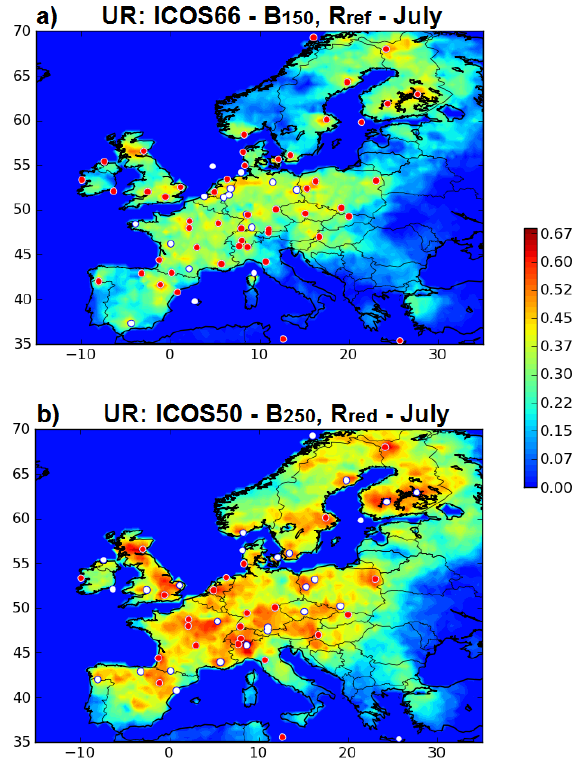
Figure 10. Uncertainty reduction (theoretically comprised between 0 and 1) for a 2-week-mean NEE at 0.5 ◦ horizontal resolution in July when modifying the inversion configuration from the reference one; using B 150 instead of B 250 and ICOS66 (a) using R red instead of R ref and ICOS50 (b) . Red dots corresponds to the ICOS23 (b) or ICOS50 (a) sites while white dots correspond to the additional sites included in ICOS50 (b) or ICOS66 (a) , respectively. Red/blue col- ors indicate relatively high/low uncertainty reduction (with min = 0 and max = 0.68 in the color scale).